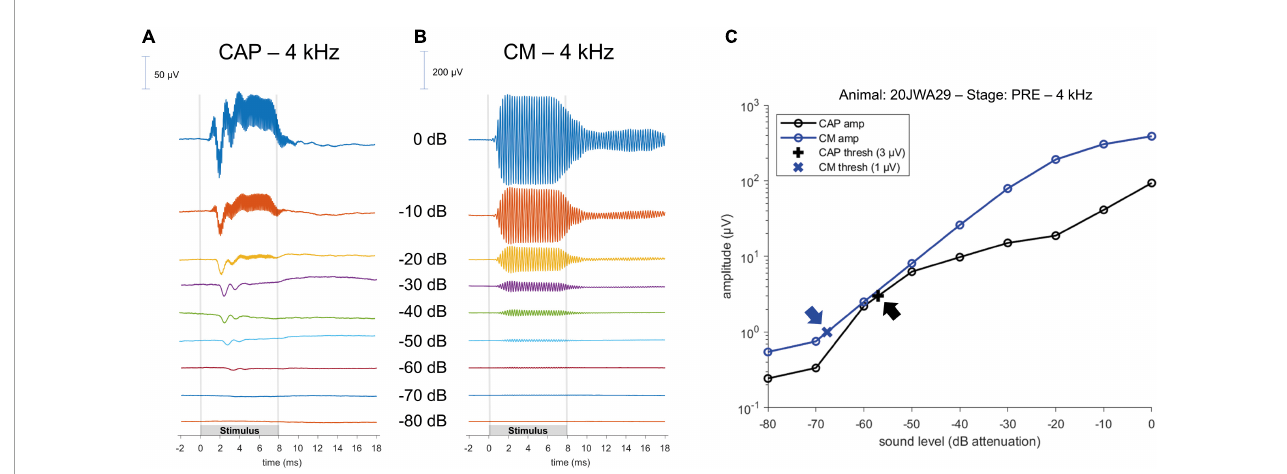
FIGURE4 Example of a CAP; (A) and a cochlear microphonics (CM; B ) response to a 4 kHz tone across different sound levels. Stimulus started with maximum sound level (in this instance of 4 kHz, at 104 dB SPL) and was attenuated in 10 dB steps until the CAP or CM response was not visible anymore. Subsequently, an input/output curve was constructed, and the threshold was interpolated using pre-defined threshold criteria (C) ; arrows point to the thresholds.